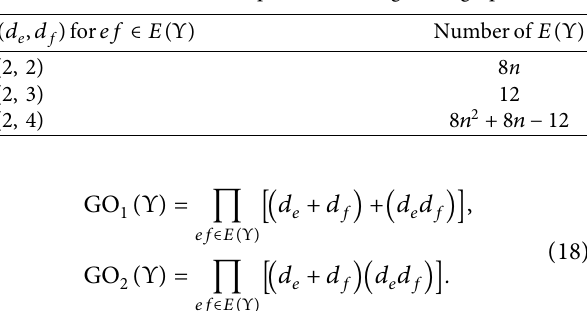
Figure 4: Saztec (4). Table 1: Describes the partition of edges for graph Y